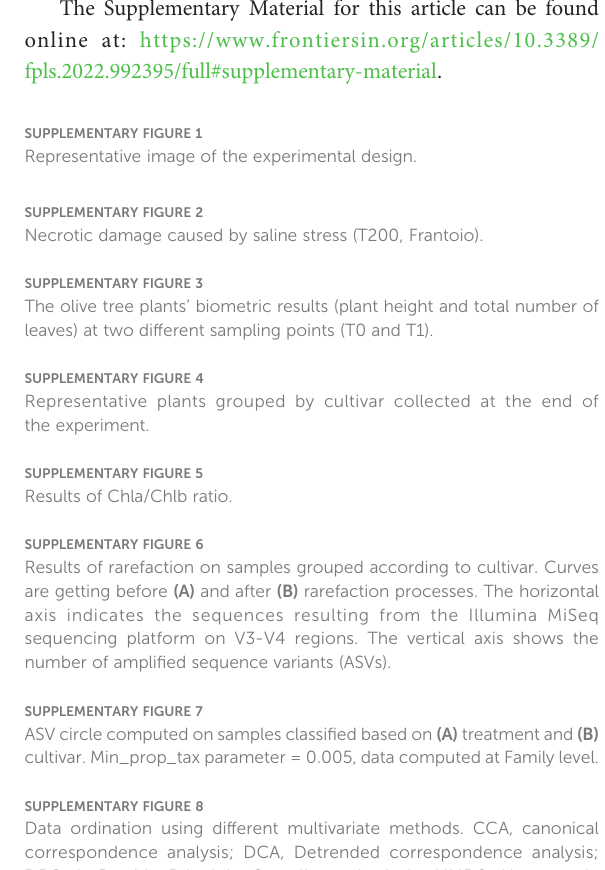
SUPPLEMENTARY FIGURE 1 Representative image of the experimental design.